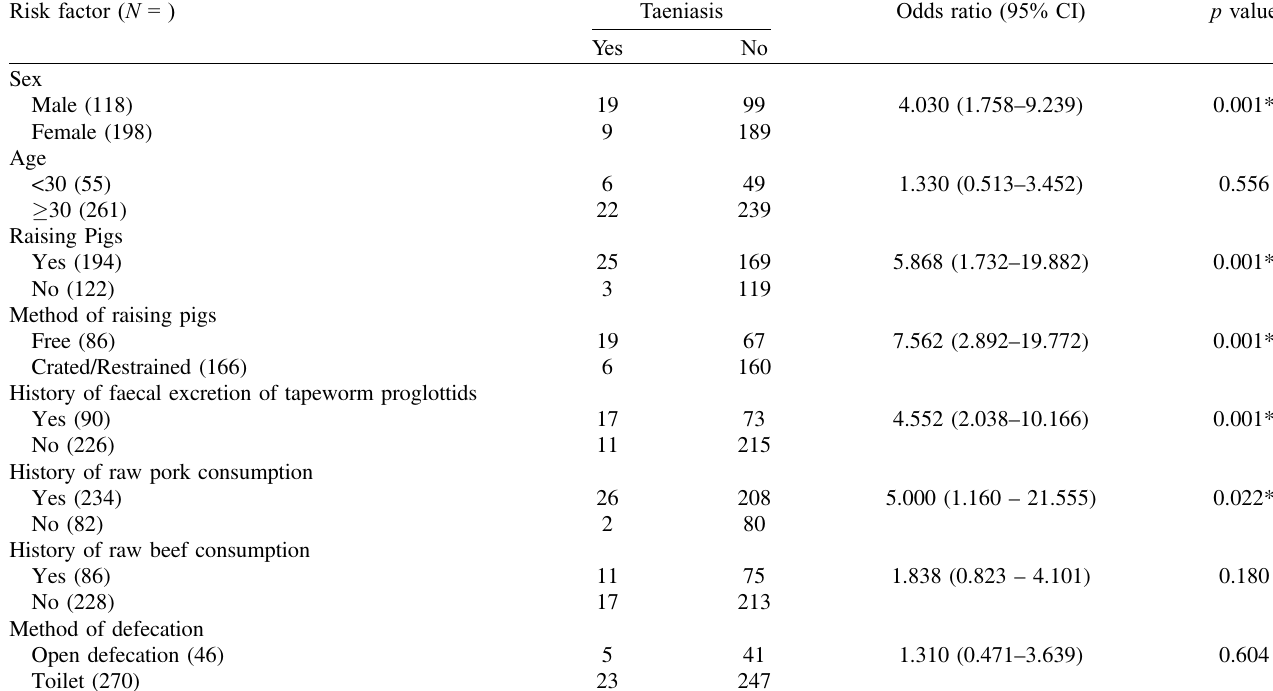
Table 5. Occurrence of taeniasis in relation to risk